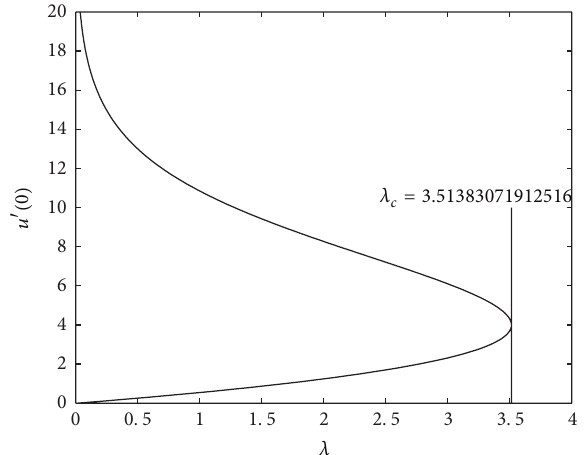
Figure 1: Bifurcation diagram for Bratu problem (7).